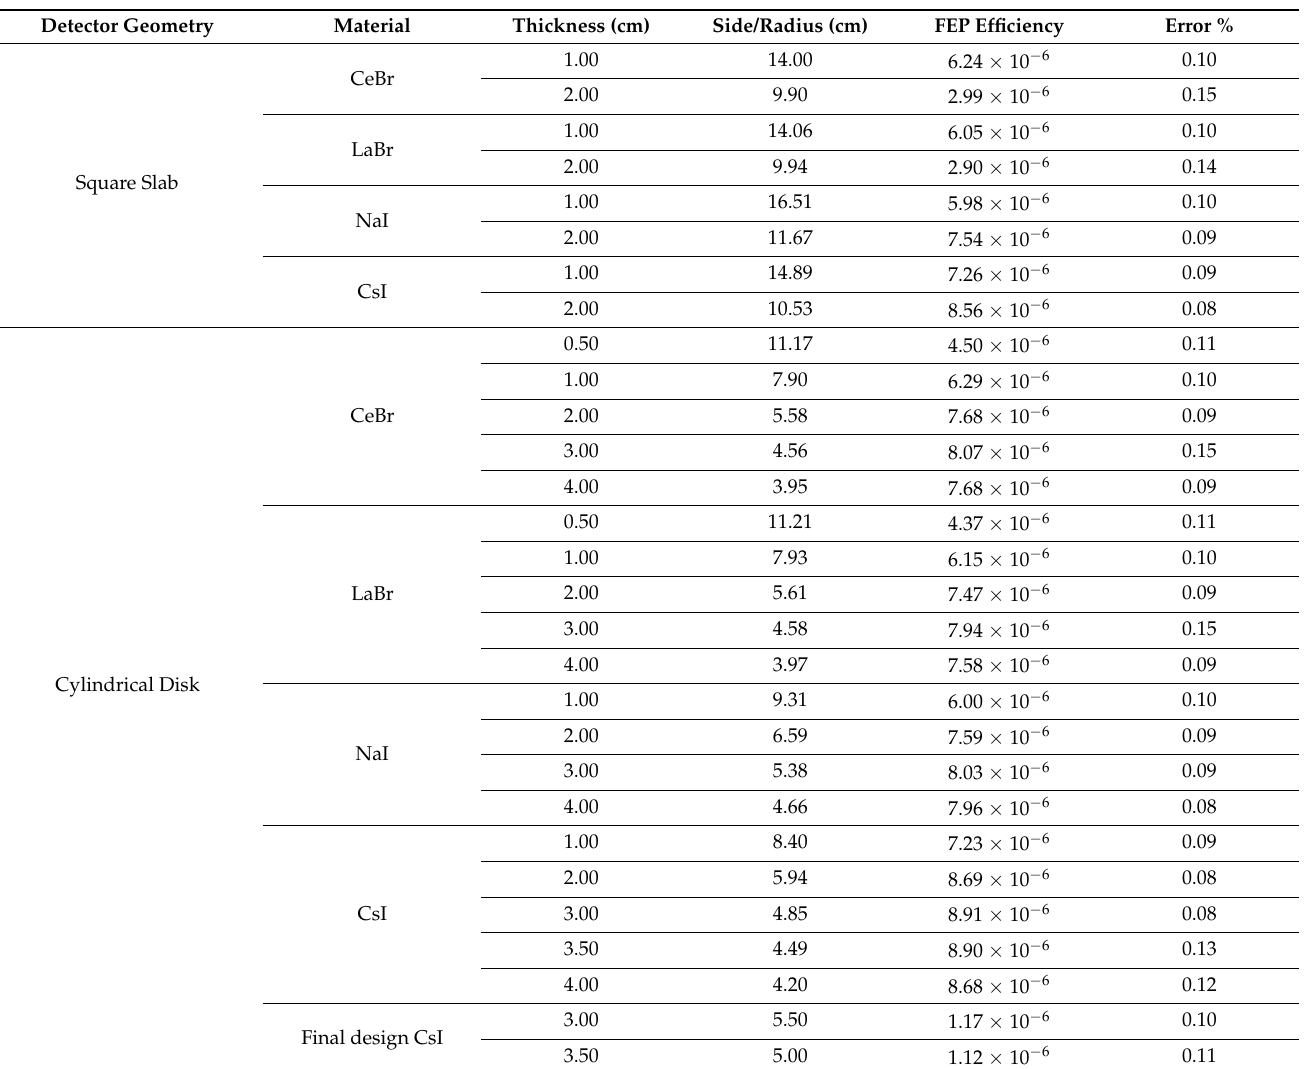
Table 1. List of geometric parameters for all Penelope Monte Carlo simulations and the full energy peak efficiency with their respective percentile error. The simulations were done with the detector crystal and a 1-mm-thick aluminum housing. The Co-60 point source was placed 5 m below the detector and the two main gamma peaks were combined for the full energy peak efficiency. Detector